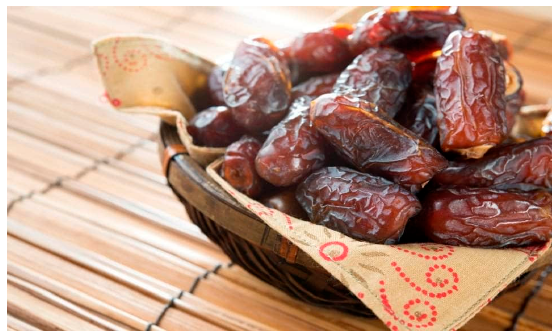
Figure 14. Sample of Al-mabroum dates.